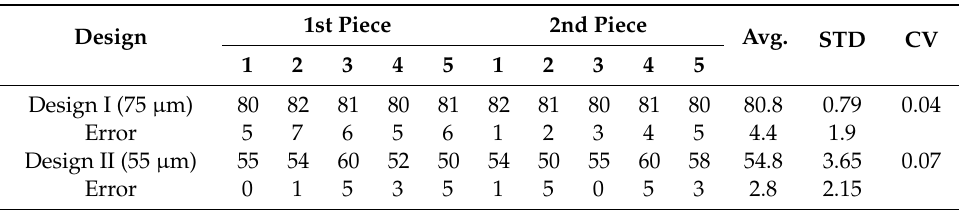
Table 1. Uniformity in thickness of PDMS membrane. (Unit: µ